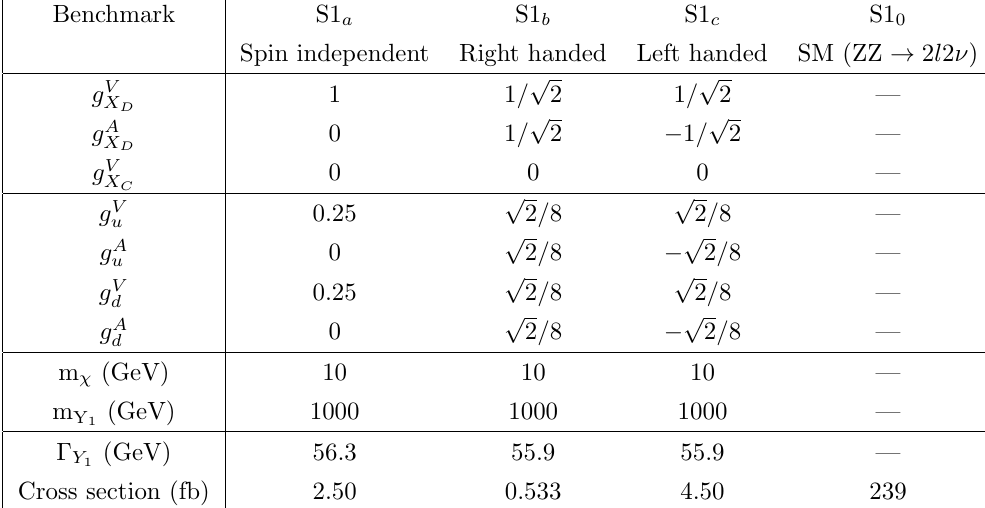
Table 2 . Benchmark scenarios with a spin-1 mediator.